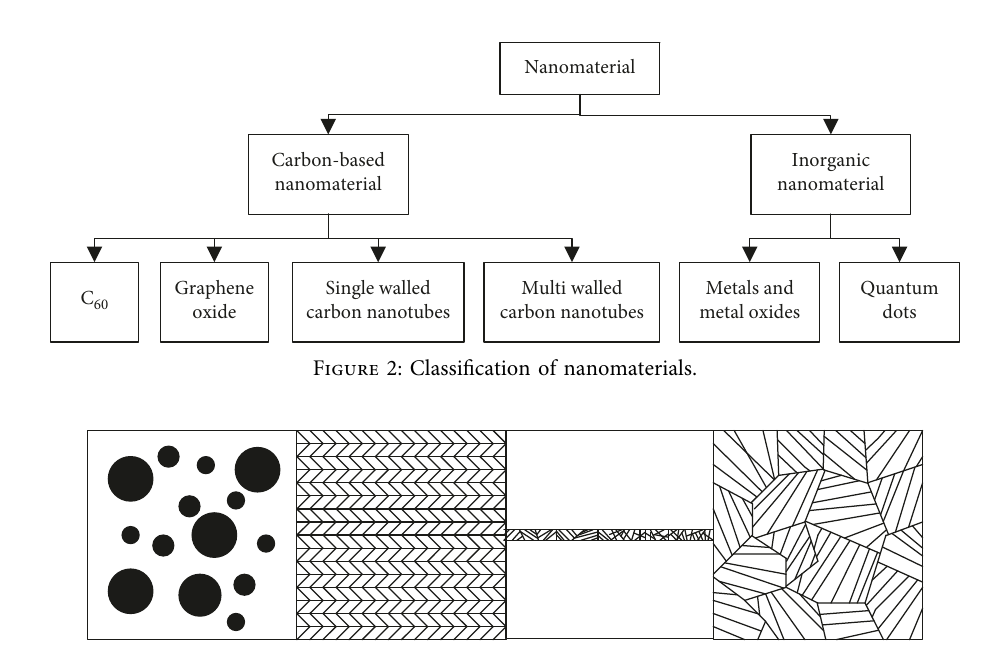
Figure 1: Basic topology of